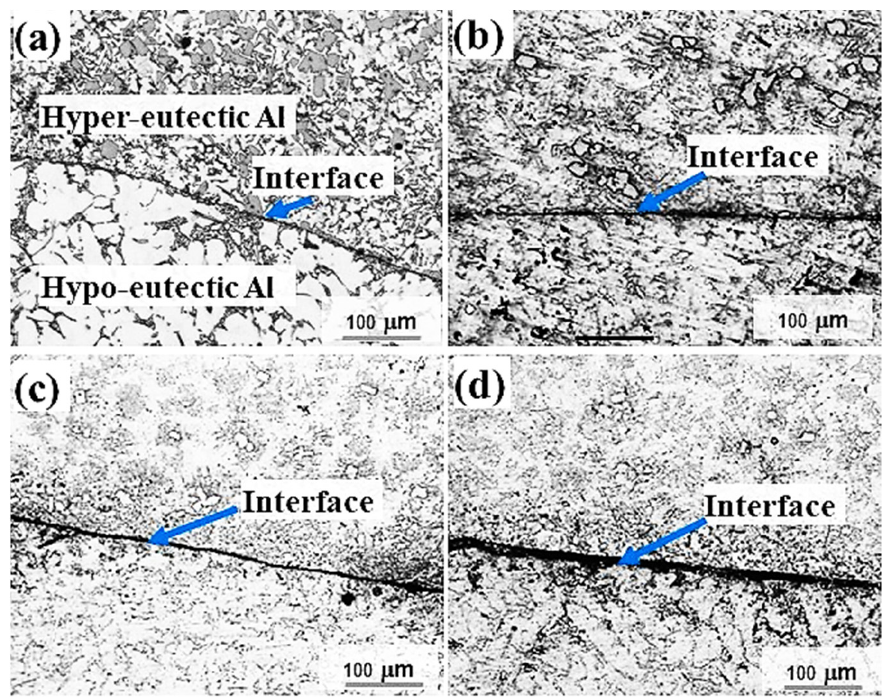
Figure 3. Interfacial microstructure of Al/Al bimetal casting in sand mould for four different time intervals: ( a ) 60 s, ( b ) 75 S, ( c ) 90, and ( d ) 120 s.